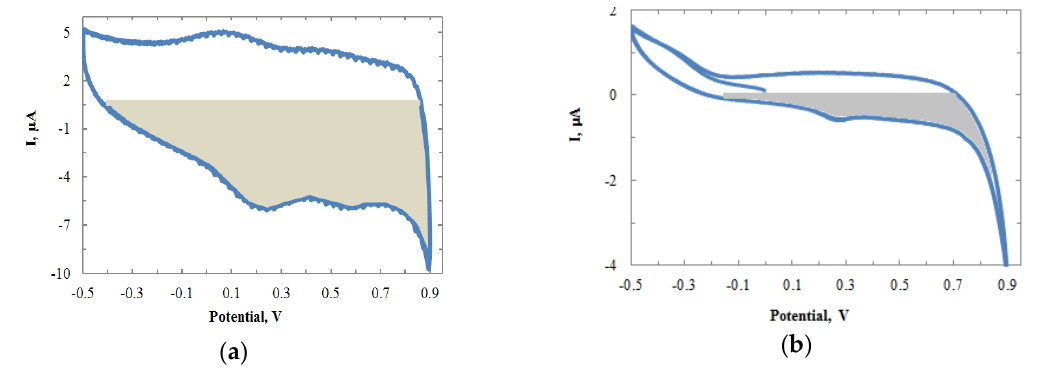
Figure 3. CV plots of ( a ) IrO x film versus an Ag/AgCl electrode in 1× PBS at 300 mV/s; and ( b ) Au film under the same condition. Grey areas were used for calculation of integral regions for Au and IrO x .